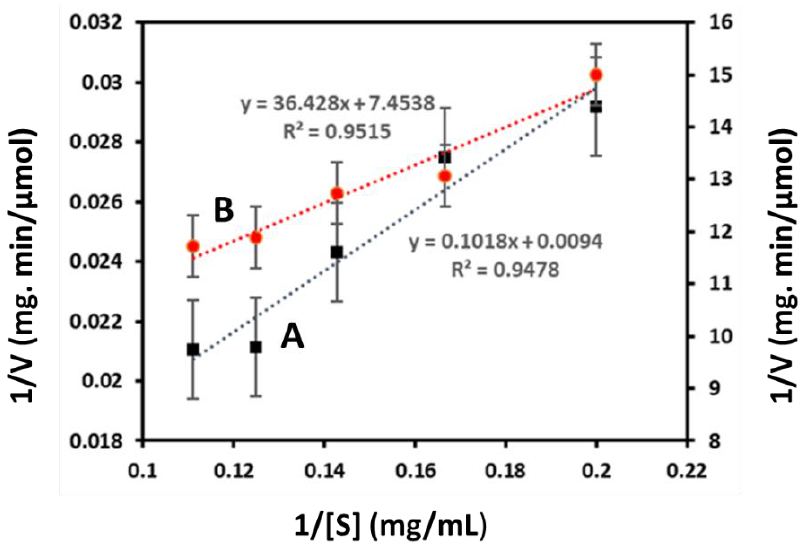
Figure 3. Lineweaver-Burk plots of free and immobilized Man/Cel5B. (A) Free Man/Cel5B (B) Immobilized Man/Cel5B.